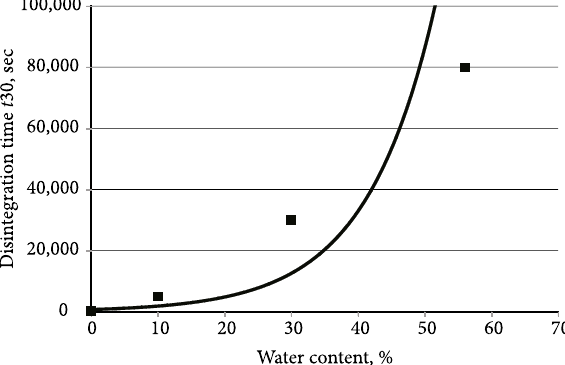
Fig. 4. Diagram of disintegration time depending on water content after